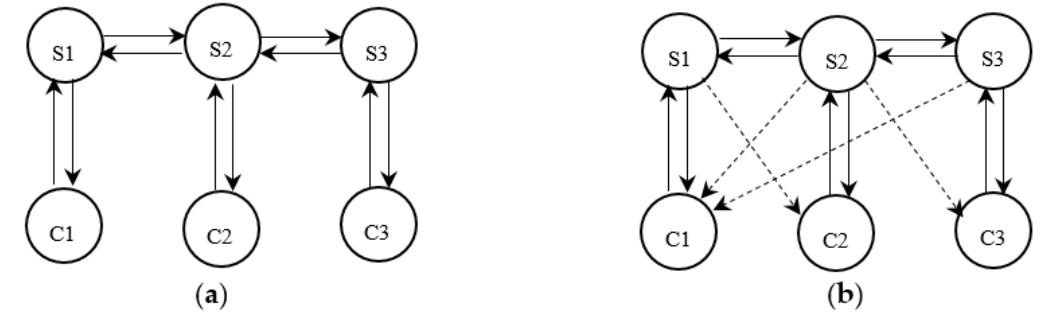
Figure 9. Decentralized and distributed control strategies (S-system and C-controller): ( a ) decentralized control strategy and ( b ) distributed control strategy.